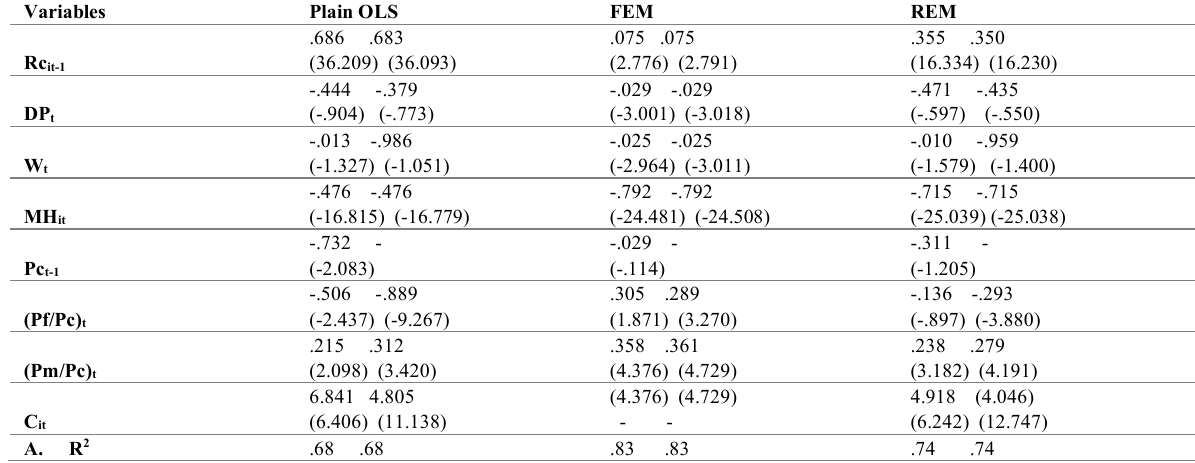
Table 5: Regression Results for the Aggregate Model (t-statistics in